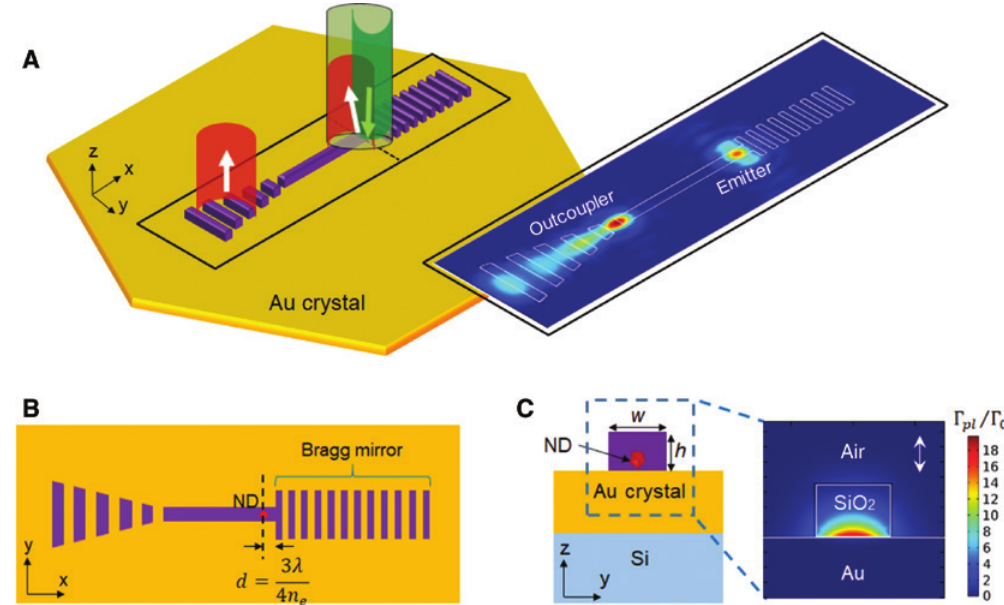
Figure 2: Deterministic emitter-waveguide interface for highly directional light emission. (A, B) Schematic of the device layout and working principle. Using optical positioning of bright centers in NDs and electron beam lithographic alignment, dielectric nanoridges were fabricated atop gold crystals, so that the preselected ND is embedded in the nanoridge and positioned in the second constructive interference fringe of the RBG mirror (A, B). Simulated far-field image for the coupled system (A, right). (C) Mode profile indicates distribution of Purcell enhancement ( Γ w = 250 nm and h = 180